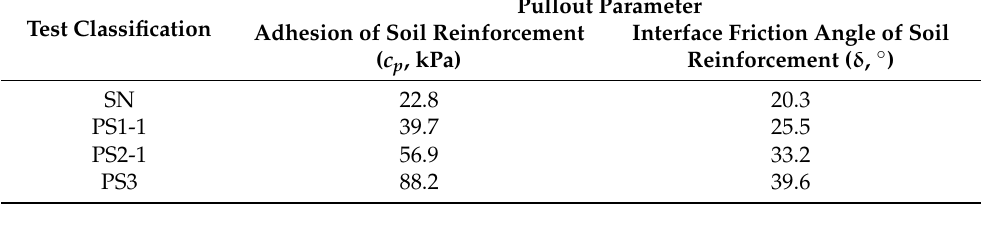
Figure 6. Relationship between normal stress and bearing strength.